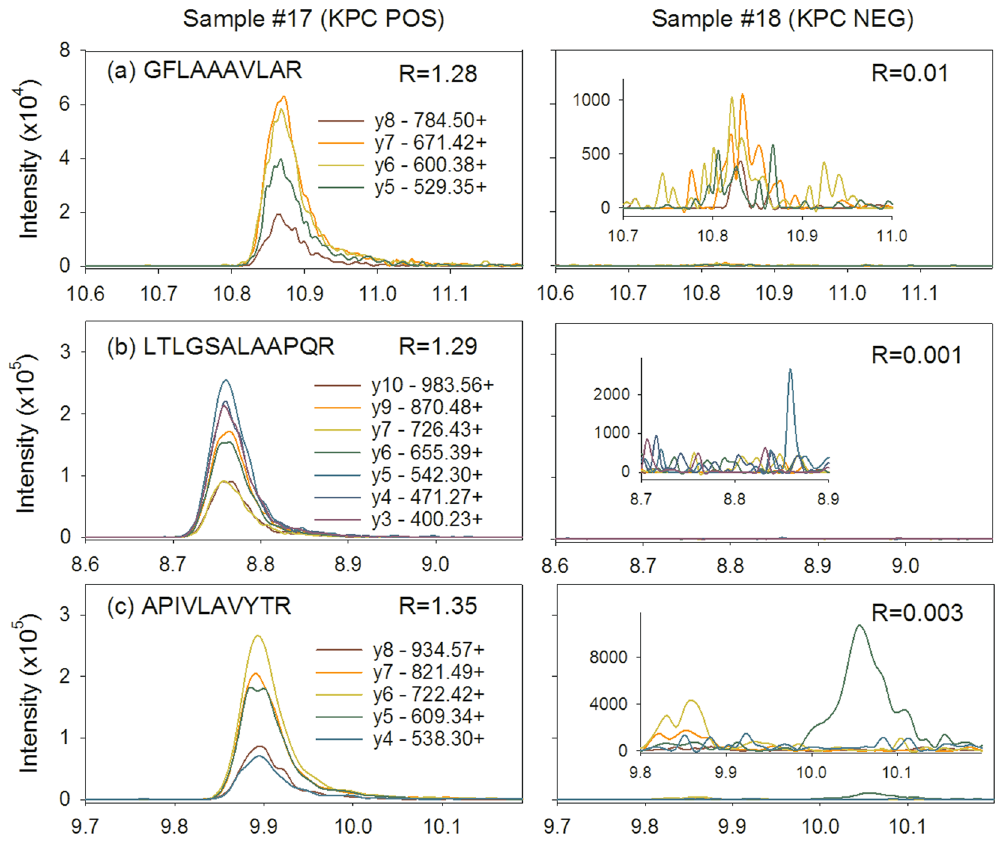
Figure 3. The LC-MS/MS chromatograms of the three chosen peptide markers are shown for two consecutive validation test set samples to demonstrate positive signals, noise, and carryover effects: ( a ) is GFLAAAVLAR, ( b ) is LTLGSALAAPQR, and ( c ) is APIVLAVYTR. Sample #17 is KPC-positive, and #18 is KPC-negative. The outside axes are drawn to the same scale in all figures. Given the very high positive-to-negative signal ratio, an inset is included with a zoomed-in vertical scale for sample #18. Normalized Intensity ratios for the three peptides in specimen #17 (KPC-positive) ranged from 1.28–1.35. Normalized intensity ratios for the three peptides in specimen #18 (KPC-negative) ranged from